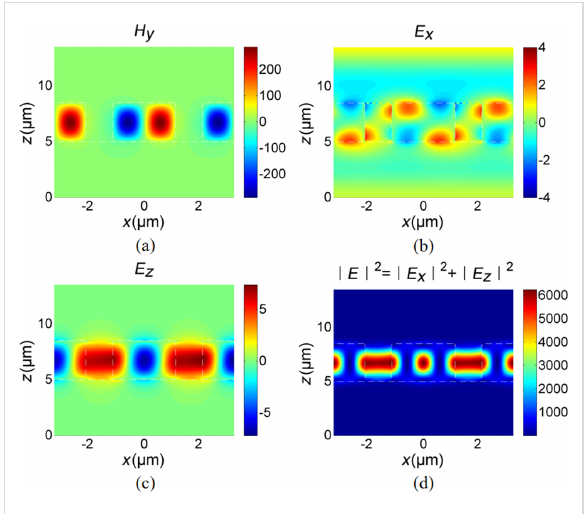
Figure 3: Electromagnetic field distributions: (a) real( H y ), (b) real( E x ), (c) real( E z ), and (d) | E | 2 = | E x | 2 + | E z | 2 . The regions enclosed by the white dash line are the dielectric grating. A graphene monolayer, which cannot be displayed due to its ultrathin thickness, is attached to the dielectric grating. The origin of the z -axis is located at a surface 5 μ m below the dielectric grating.